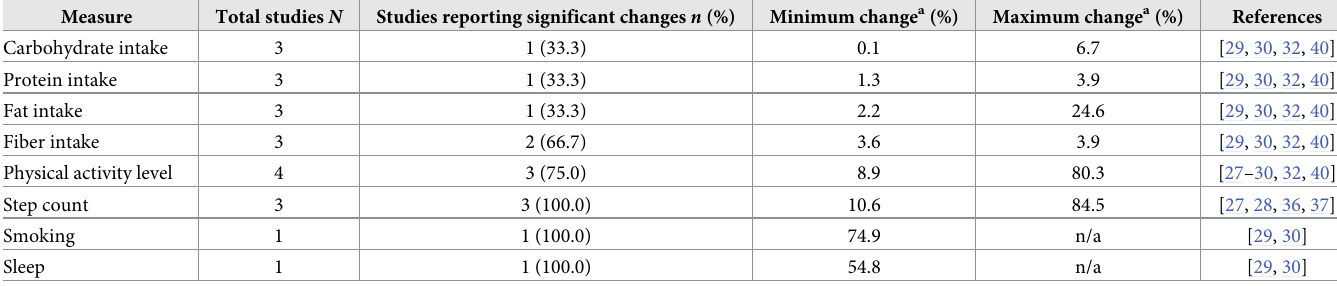
Table 5. Changes in nutrient intake, physical activity, and lifestyle